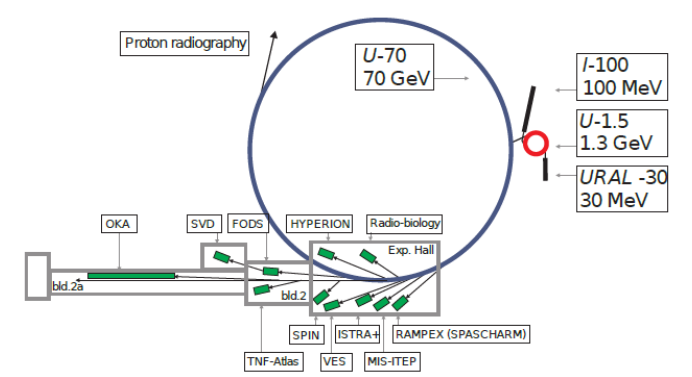
Figure 1. Accelerator Complex U70, beam transfer line network and fixed-target experimental facilities